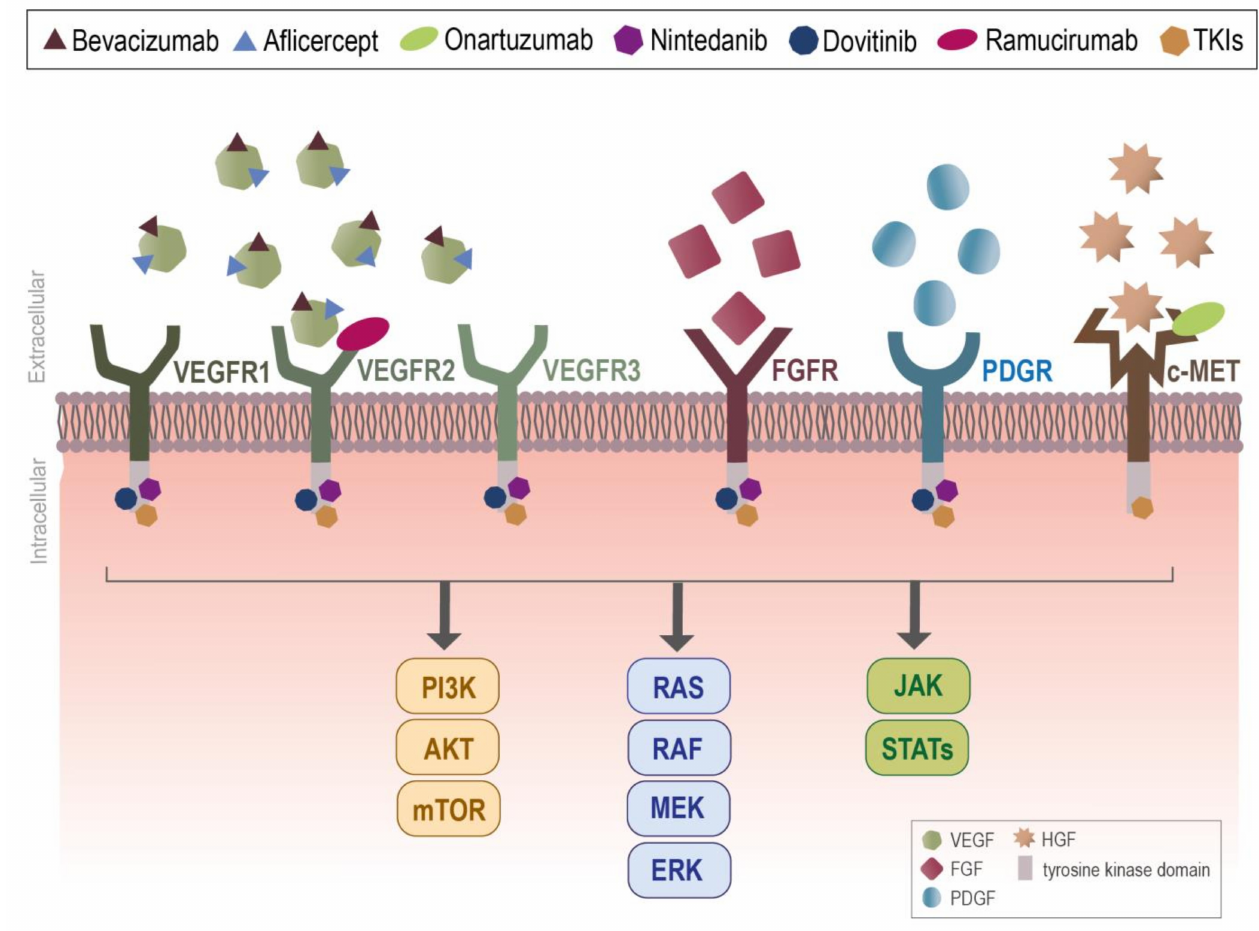
Figure 2. Anti-angiogenic drugs can act as decoy agents, monoclonal antibodies, or tyrosine kinase inhibitors. Bevacizumab was the first anti-angiogenic drug approved for human use, however, its use as monotherapy is inefficient. Compensatory mechanisms of other angiogenic mediators induces a switch in the vascular endothelial growth factor (VEGF)-dependent state to a VEGF-independent angiogenic process and leads to patient resistance to VEGF signaling pathway blockade. Nowadays, a new class of drugs, by blocking other effectors in angiogenic signaling pathways, try to improve the clinical efficacy of anti-angiogenic therapies. In some scenarios, the use of anti-angiogenic therapies delays the disease outcome of cancer patients, still other patients do not have any additional benefits. The major signaling pathways downstream of VEGFRs, FGFRs, PDGRs, and c-MET in endothelial cells (ECs) are PI3K-AKT-mTOR, Ras-Raf-MEK-ERK, and JAK-STATs, which are pivotal for EC survival, proliferation, and migration. AKT: Protein kinase B; ERK: Extracellular-signal-regulated kinase; FGF: Fibroblast growth factor; FGFR: Fibroblast growth factor receptor; HGF: Hepatocyte growth factor; JAK: Janus protein tyrosine kinase; MEK: Mitogen-activated protein kinase; mTOR: Mammalian target of rapamycin; PDGF: Platelet-derived growth factor; PDGFR: Platelet-derived growth factor receptor; PI3K: Phosphoinositide 3-kinases; Raf: Serine/Threonine Kinase; STAT: Signal transducer and activator of transcription protein; VEGF: Vascular endothelial growth factor; VEGFR: Vascular endothelial growth factor